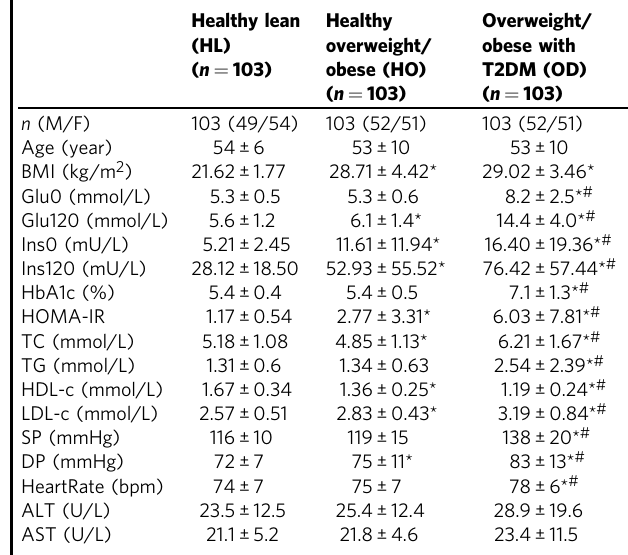
healthy overweight/obese (HO) and overweight/obese with T2DM (OD) subjects in the fi rst cross-sectional